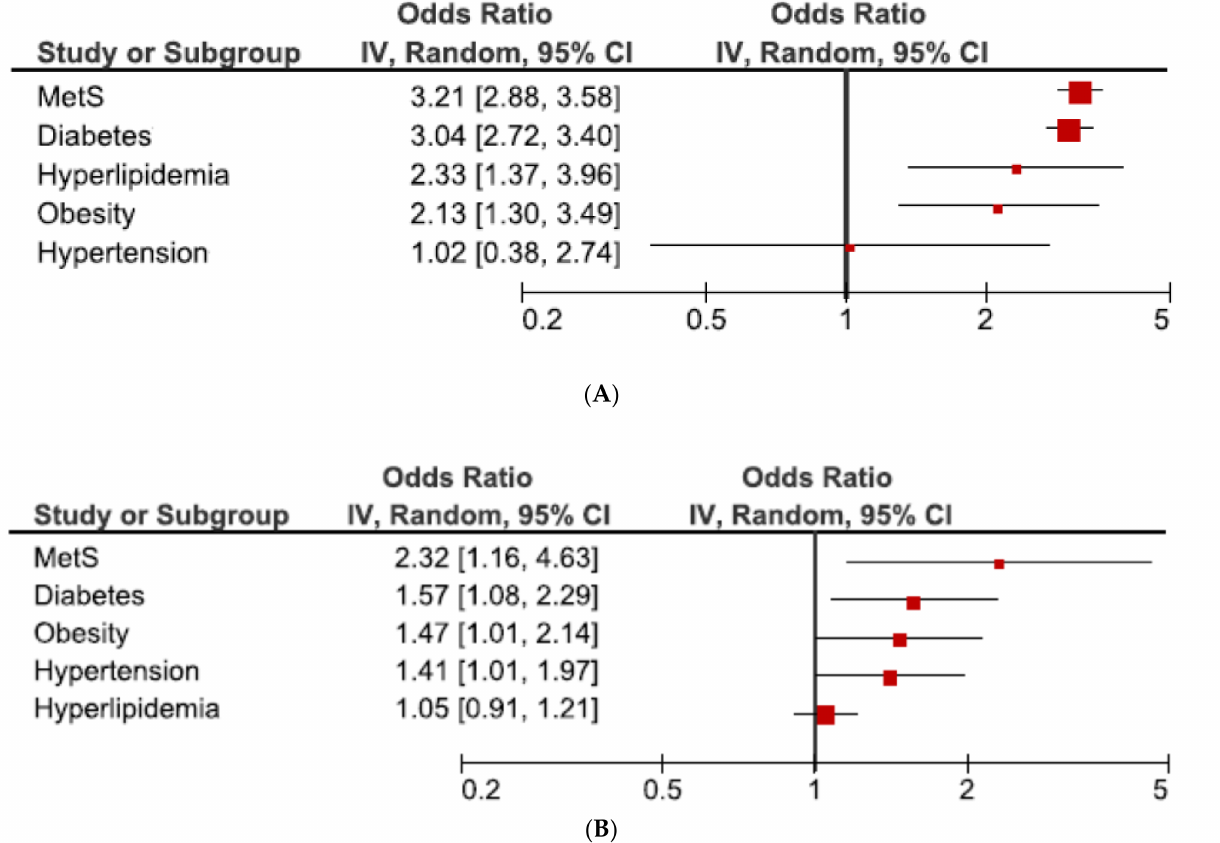
Figure 2. Forest plot of the association between MetS and its components with SARS ( A ) and mortality ( B ) in patients with COVID-19. Abbreviations: CI: confidence interval; IV: inverse